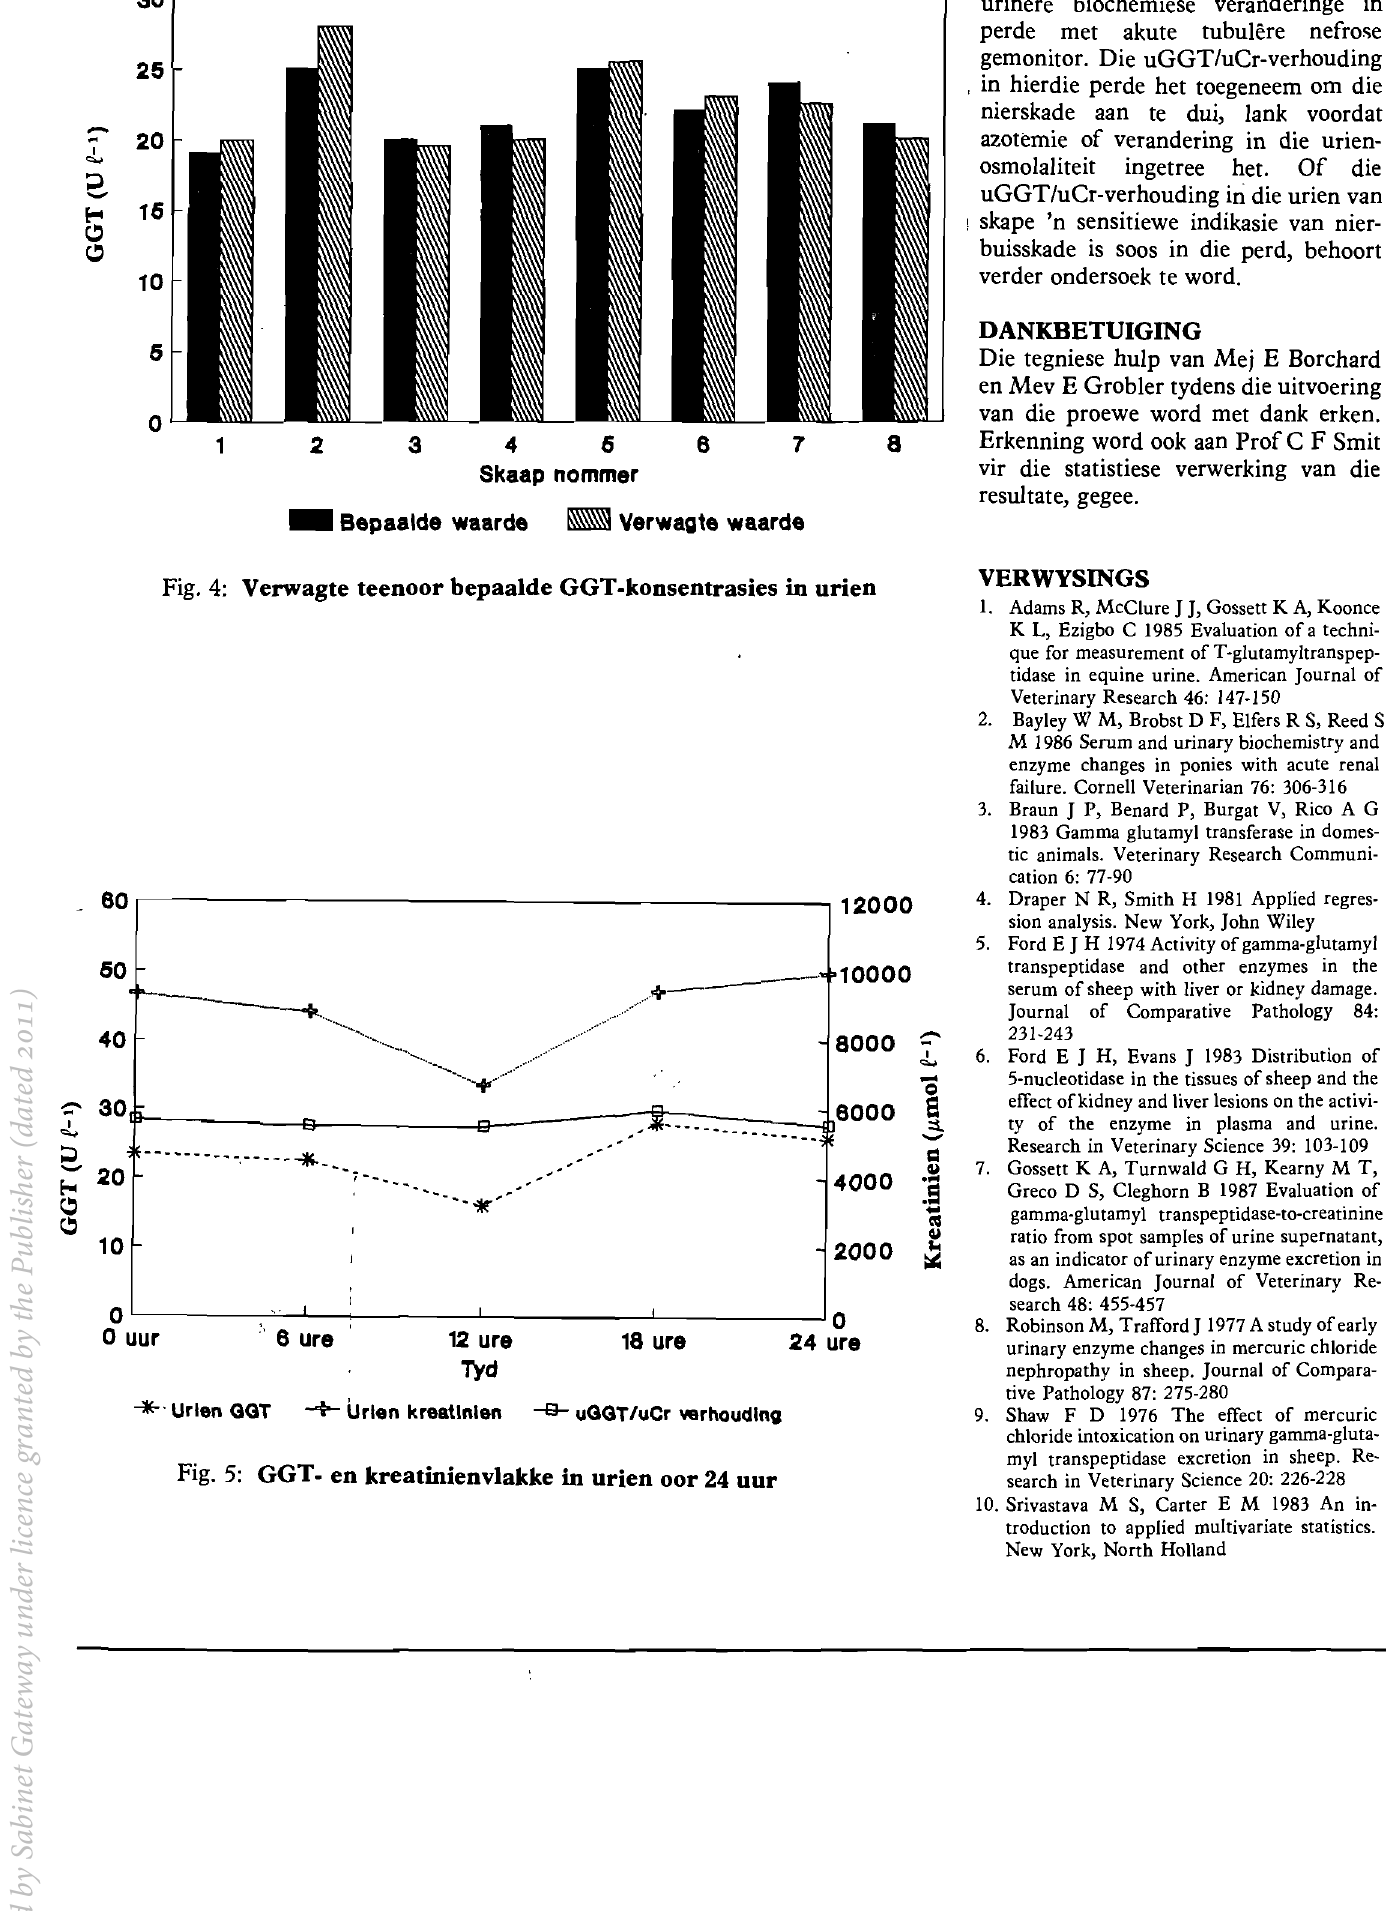
0038-280.9 Tydskr.S.A/r. vet. Ver.